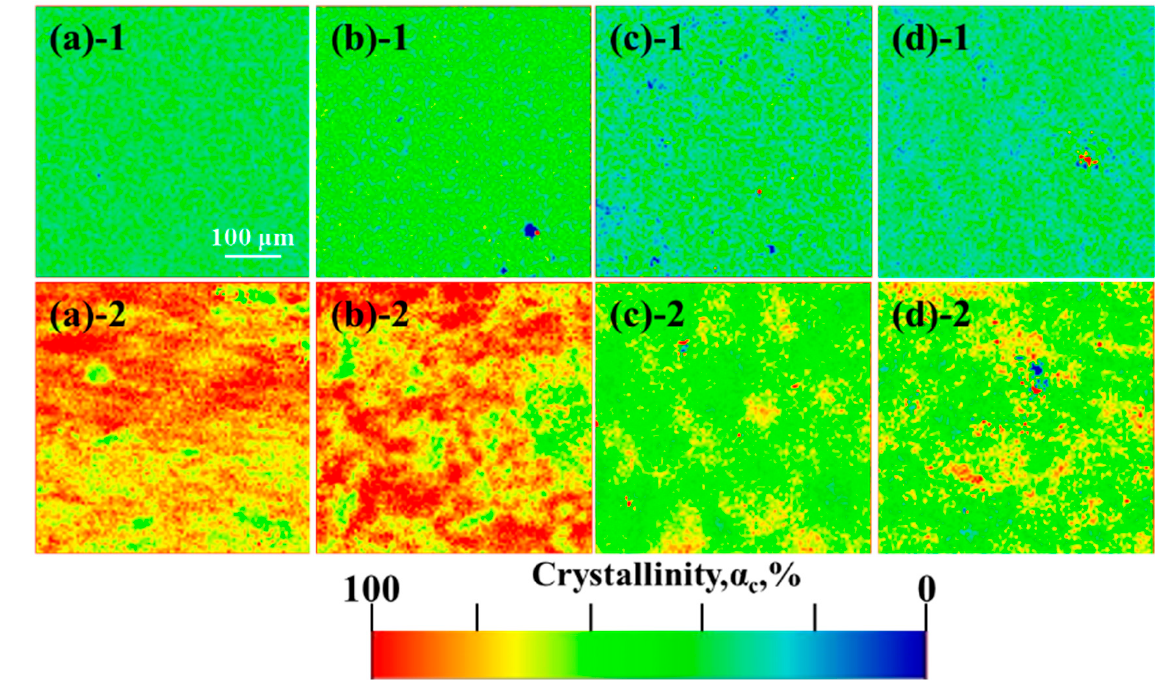
Figure 4. Surface crystallinity distribution of Raman mapping of UHMWPE and UHMWPE/PP under different processing methods: ( a ) CM-UPE; ( b ) ERE-UPE; ( c ) ERE-85/15; ( d ) TSE-85/15; “ 1 ” and “ 2 ” stand for before friction and after friction, respectively.